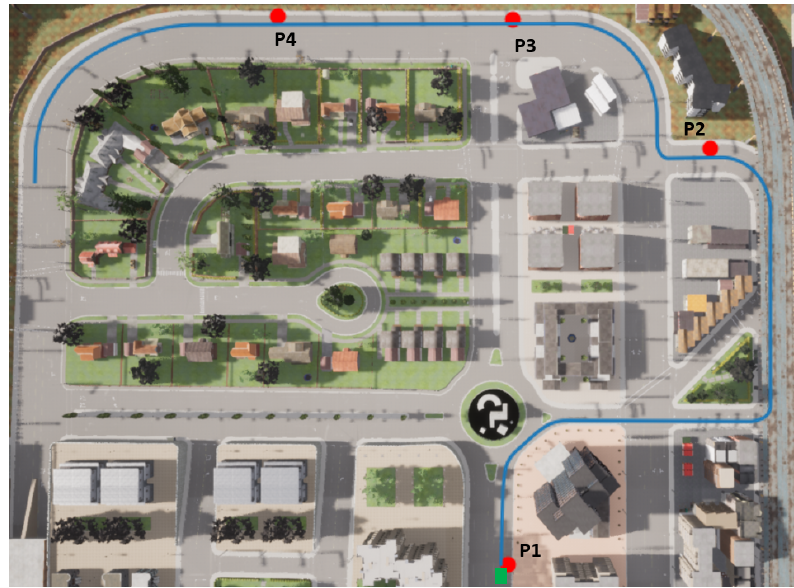
Figure 13. Use case scenario.